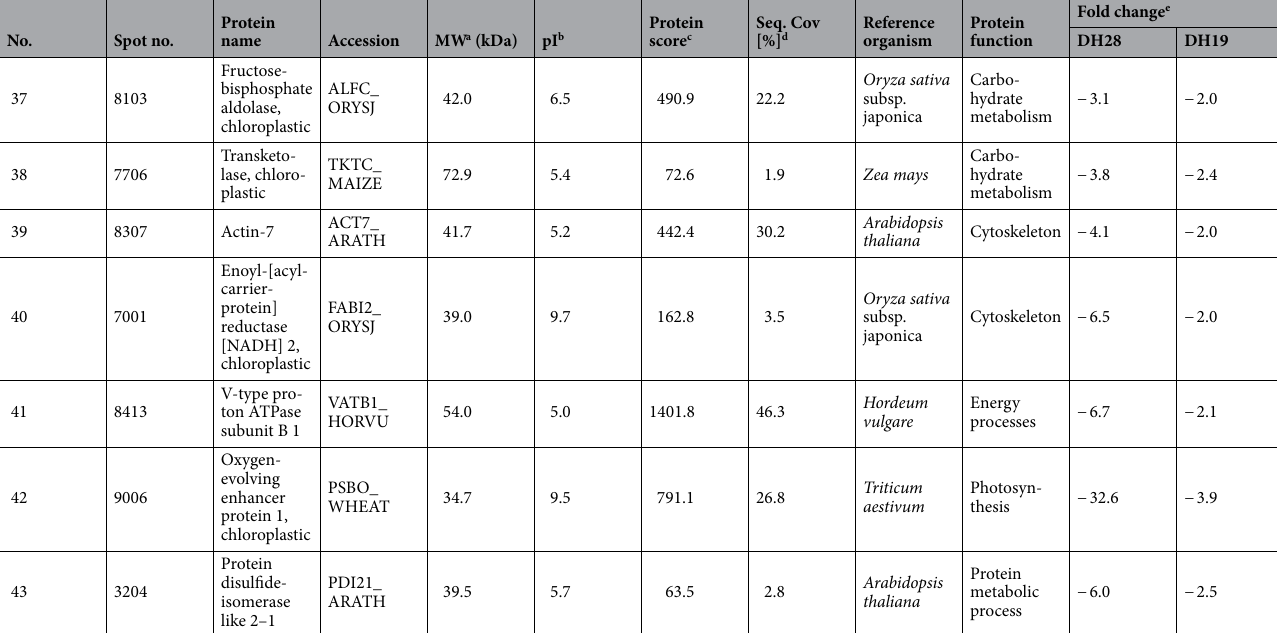
Table 1. A list of anther proteins, which accumulation significantly changed after microspore embryogenesis (ME) inducing triticale tillers treatment combining low temperature (3 weeks at 4 °C) with the application of 5.0 µM of 5-azacytidine, DNA demethylating agent. Two DH lines of triticale differ significantly in ME responsiveness (highly recalcitrant DH19 and responsive DH28). Swiss-Prot database was used for protein identification. The results are based on nano LC–MS/MS analyses. a The theoretical molecular weight (MW. kDa) and b isoelectric point (pI) retrieved from the protein database. c The score and d protein sequence coverage (Score in Flex Analysis software). e Change in abundance was calculated by dividing the mean